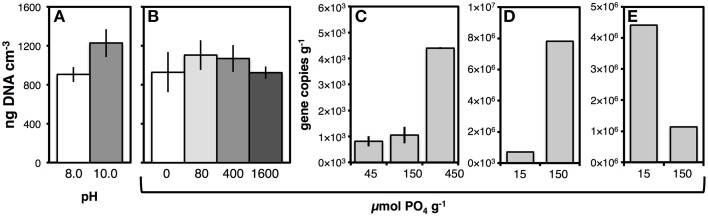
(A) Effect of pH of lysis buffer I on DNA yields from sediment of Aarhus Bay Station M5. (B) Effect of adding different amounts of pyrophosphate on DNA yields from Aarhus Bay Station M5. The PO4 amounts shown correspond to 0, 40, 200, and 800 μmol pyrophosphate g−1 sediment. (C–E) Effect of adding different amounts of dNTPs—expressed in PO4 monomer units—on extracted archaeal gene copies g−1 from sediment of Subglacial Lake Whillans (C), and bacterial gene copies g−1 from sediment cuttings (D) and drilling mud (E). Error bars in (A,B) indicate standard deviations of triplicate DNA extractions. Error bars in C indicate data ranges of duplicate DNA extractions.